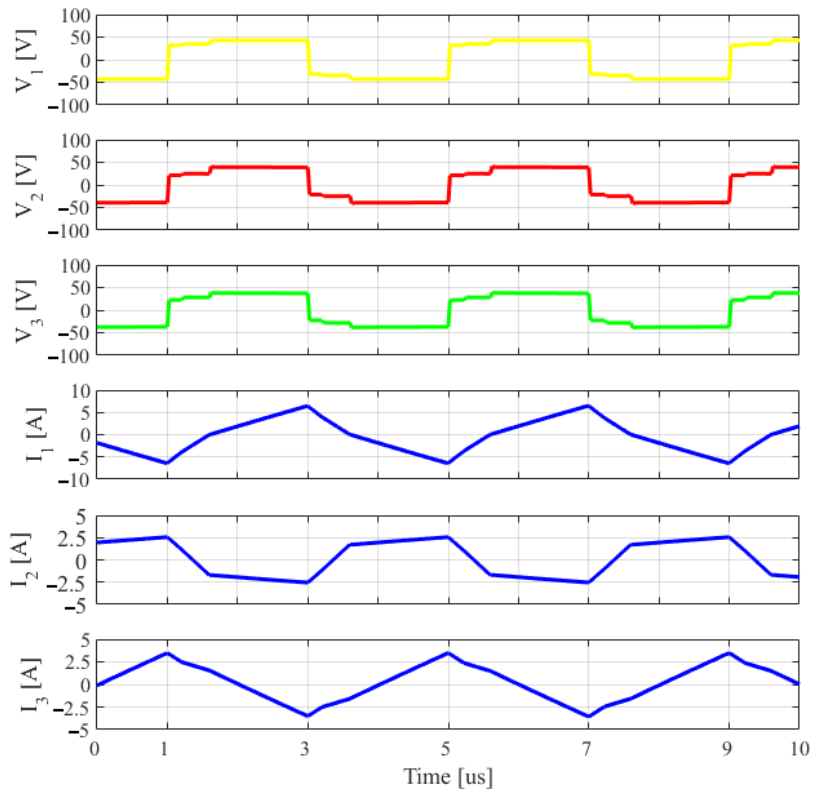
Figure 19. Simulation results of the transformer voltages V 1 (yellow), V 2 (red), V 3 (green) and currents